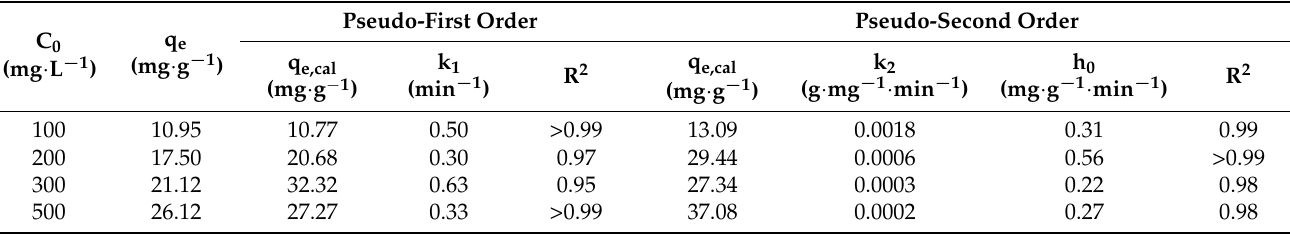
Table 2. Kinetic parameters for ACA electrode